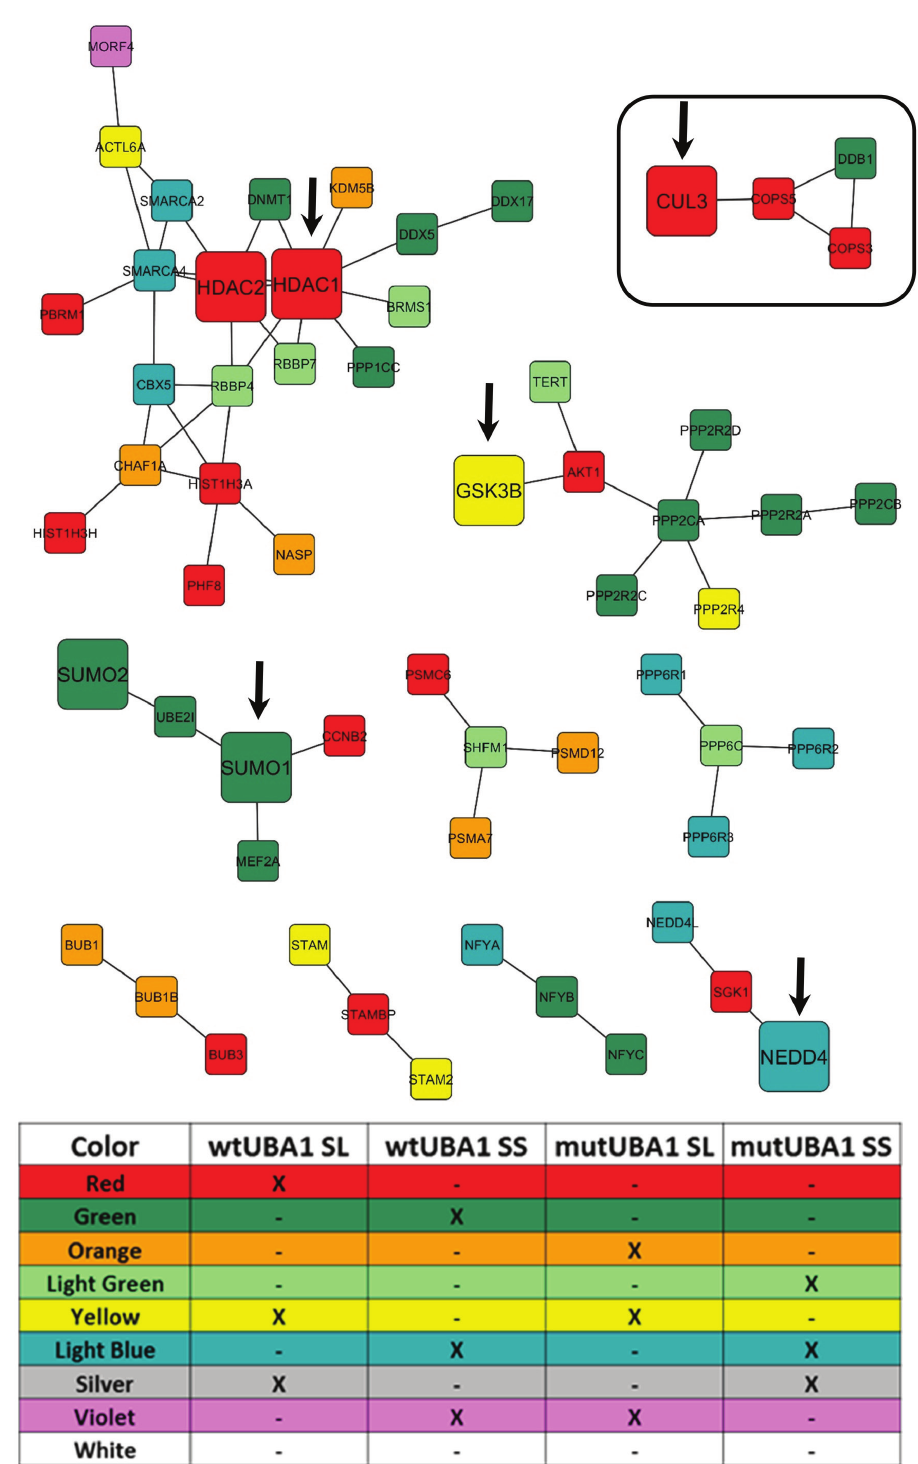
Figure 3. Human UBA1 primary gene interaction network. Human orthologs of yeast genes identified from four independent SGA screens were used to map the corresponding protein-protein interaction network. Only proteins that have experimentally verified data (STRING) supporting a physical interaction with at least two additional genes/proteins identified in the UBA1 -SGA screens are displayed. Of particular interest is the discovery of NEDD4, CUL3, GSK3, SUMO and HDAC in distinct network clusters. Proteins of interest are highlighted by a larger node size and indicated with an